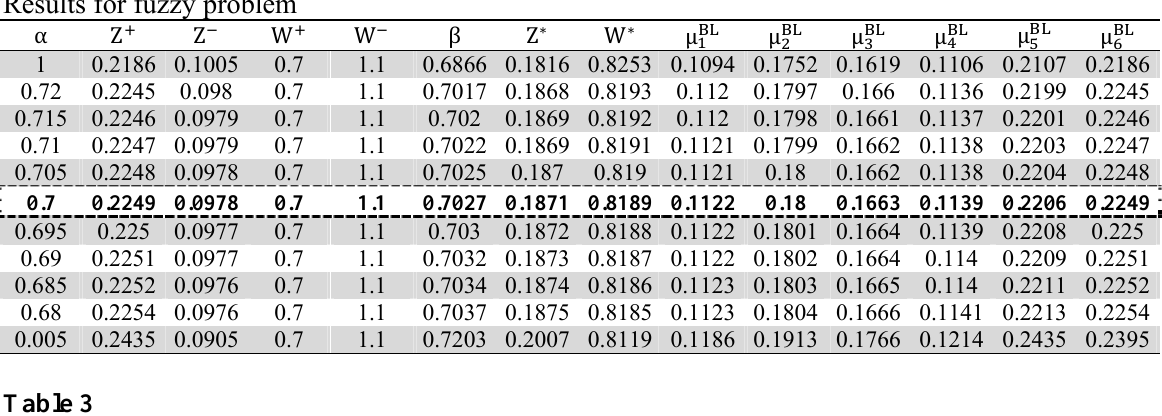
Results for non-fuzzy problem